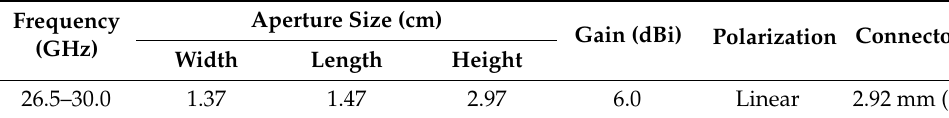
Table 4. Intercomparison Antenna Specifications.